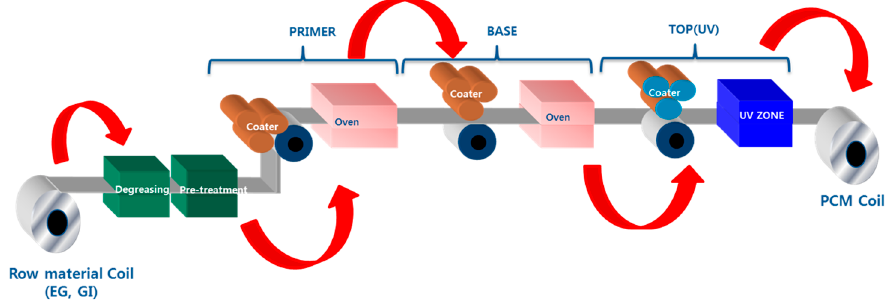
Figure 1. Schematic process of UV curing coatings for pre-coated metals.